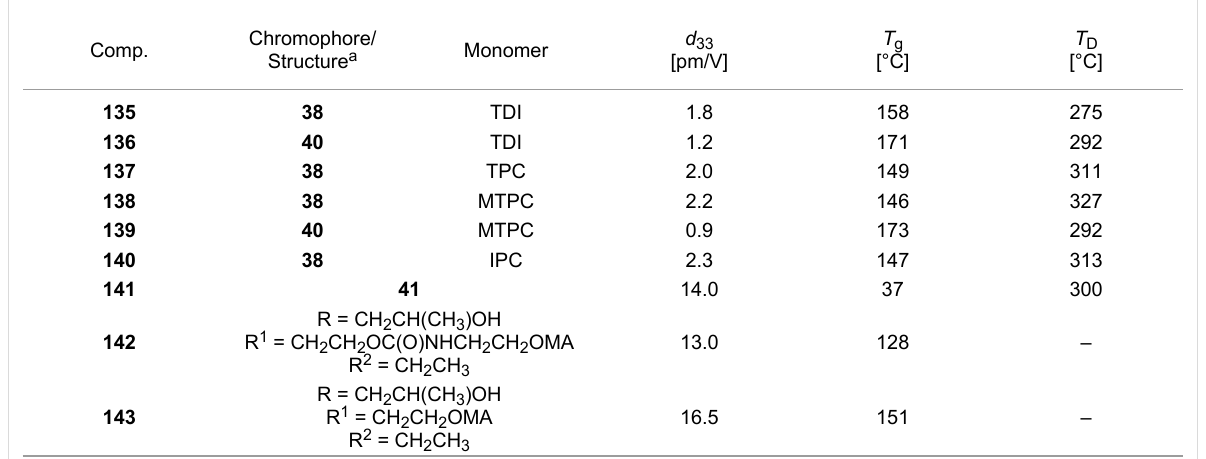
Table 16: Benzimidazole-derived chromophores embedded into a polymer 135 – 143 [62,63,65].